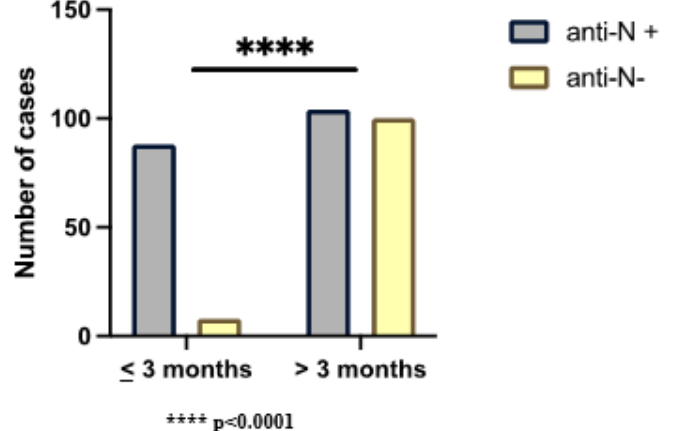
Figure 3. Number of cases seropositive or seronegative for anti-N IgG in relation to SARS-CoV-2 infection in the last 3 months and over 3 months.